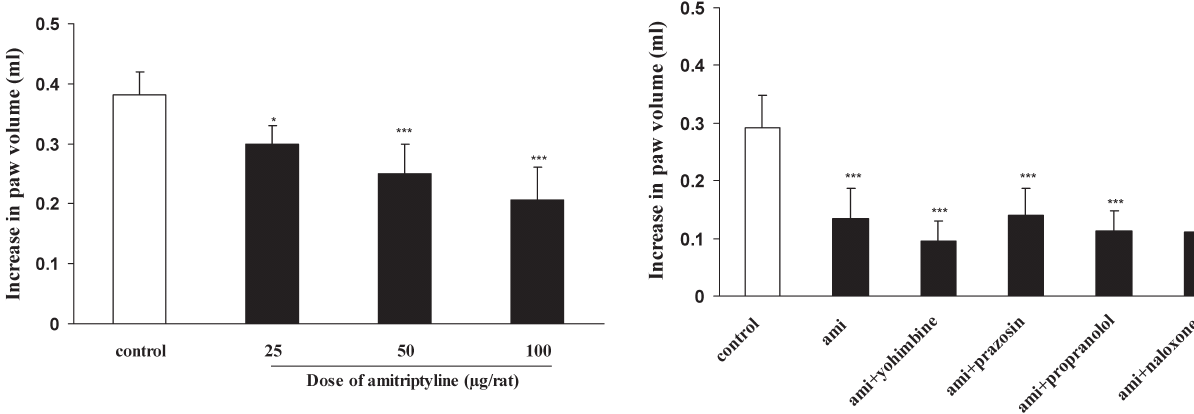
Figure 2 - Effect of intracerebroventricular injection of amitripty- line on carrageenan-induced paw edema in the rats. Amitriptyline or the vehicle was administrated 30 min prior to carrageenan (1%) injection, and the rats were evaluated for paw edema 4 h post-carrageenan injection. The values represent the mean variation in the paw volume ¡ S.D. (n=8, * P , 0.05, *** P , 0.001).